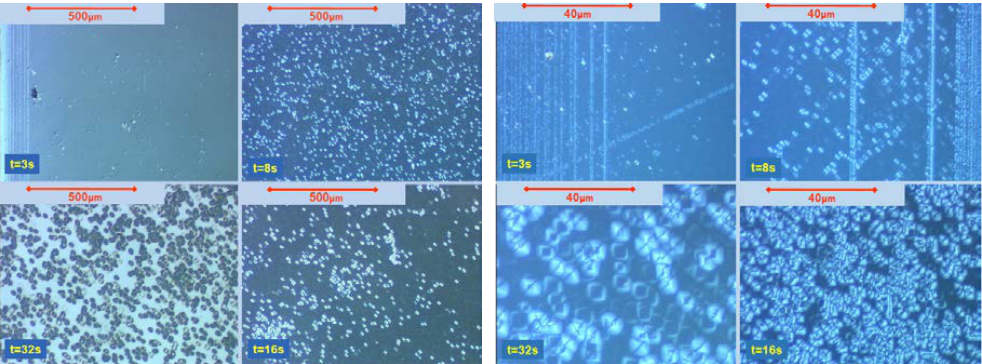
Figure 9. Collection of the optical photographs which shows the evolution of the etch pits distribution on SrTiO 3 (100) crystal for different etching time of 3s ( a , e ), 8s ( b , f ) 16s ( c , g ) and 32s ( d , h ) in low magnifications ( a – d ) and high magnifications ( e – h ). Note, that for short etching time only the region close to the edge of the crystal with dislocations (accumulated in bands) can be identified via optical (here microscopic) inspection. Note further, that time-dependent etching of the SrTiO 3 crystals was